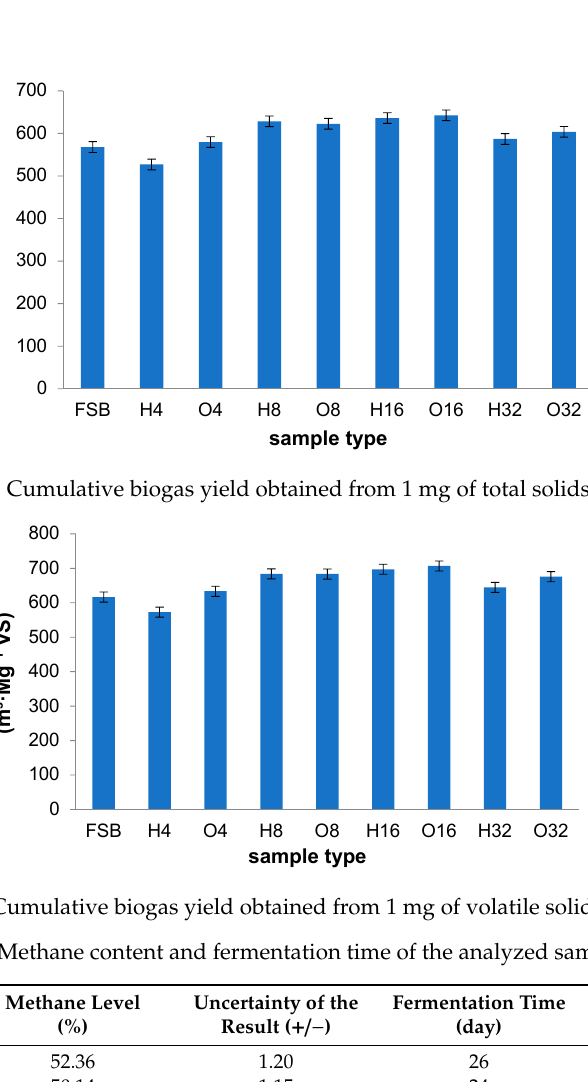
Figure 2. Cumulative biogas yield obtained from 1 mg of fresh matter (FM).